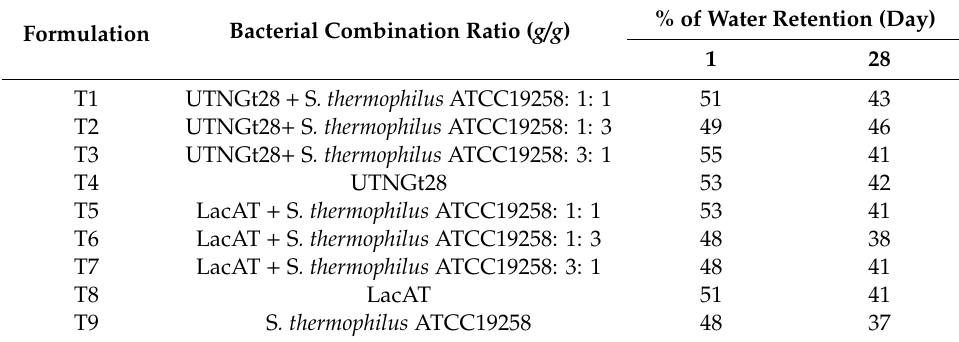
Table 3. Syneresis values of the yogurt formulations expressed as % of water